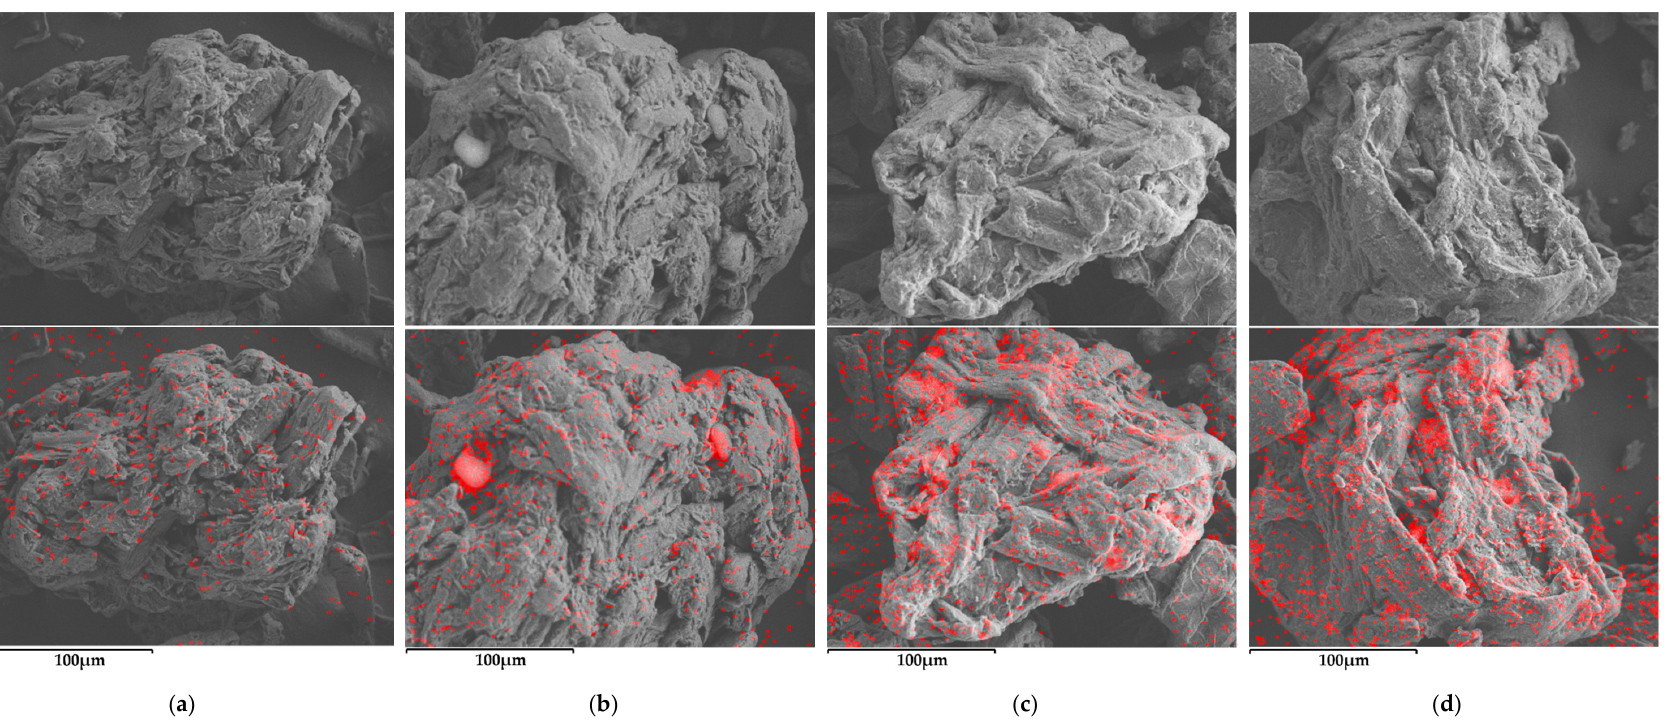
Figure 4. SEM (top) and EDS mapping (bottom) at 1K magnification of ( a ) unprocessed MCC particle and MCC particle with 1.0% A200P ( b ) after mixing in a V ‐ Blender, after processing in the conical mill 4 times at ( c ) 476 rpm and ( d ) 1762 rpm. Red dots on bottom row are EDS mapping results of silicon.